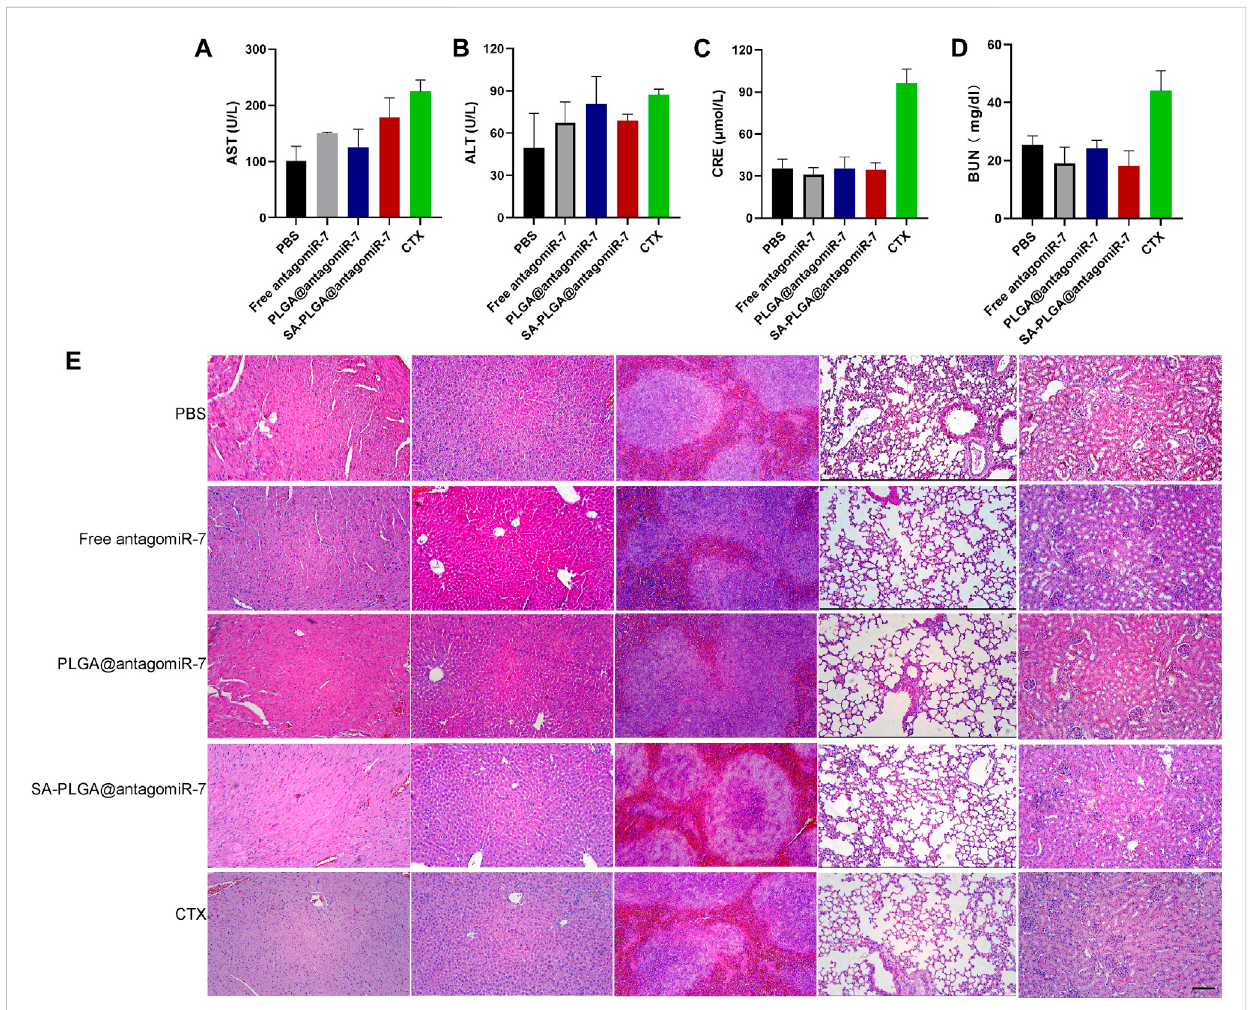
FIGURE 7 The liver and kidney function parameters of AST (A) , ALT (B) , CRE (C) , and BUN (D) in mice after 1 month of treatment were shown ( n = 3). (E) Histopathological examination of vital, visceral organs of mice treated with PBS, Free antagomiR-7, PLGA@antagomiR-7, SA-PLGA@antagomiR-7, and CTX. Scale = 100 μ m. The scale bar in the last image can be applied to other